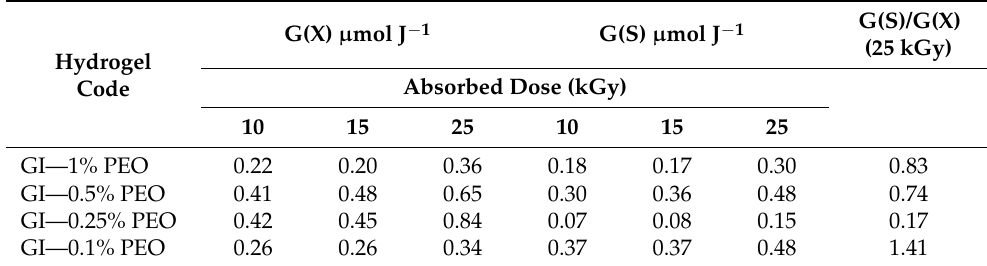
Table 2. Radiochemical yields of cross-linking G(X) and degradation Table 1. Sol-gel analysis for hydrogels with different concentrations of PEO.